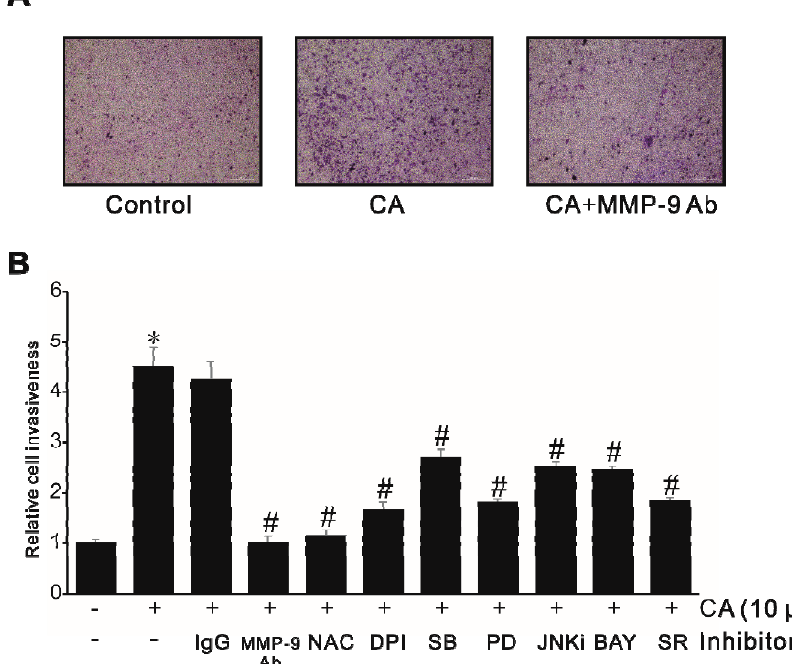
Figure 7. CA-induced cell invasion by stimulating MMP-9 expression in SW620 cells. ( A ) SW620 cells (10 5 ) were treated with 10 µ M CA in the presence or absence of anti-MMP-9 antibody in a Matrigel apparatus for 24 h. ( B ) SW620 cells (10 5 ) were treated with 10 µ M CA in the presence of nonspecific IgG (200 ng / mL); anti-MMP-9 antibody; 5 mM NAC; 10 µ M DPI; 30 µ M SB-203580 (SB); 30 µ M PD-98059 (PD); and 30 µ M JNKi, 10 µ M BAY-11-7082(BAY), or 2 µ M SR-11302 (SR) in a BIOCOATTM Matrigel apparatus. After incubation for 24 h, cells invading the undersurface of membranes were stained with a Diff-Quick stain kit and counted under a phase-contrast light microscope. Data represent the mean ± standard deviation (SD) from triplicate measurements. * p < 0.05 versus control; # p < 0.05 versus CA only (B).